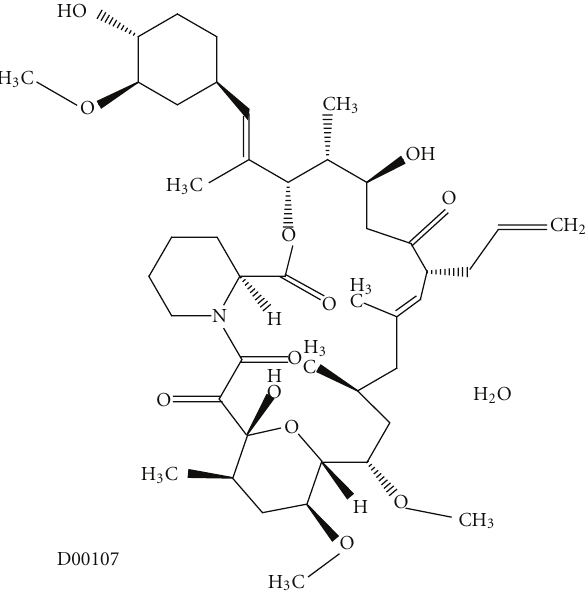
Figure 5: Molecular structure of tacrolimus extracted from KEGG database